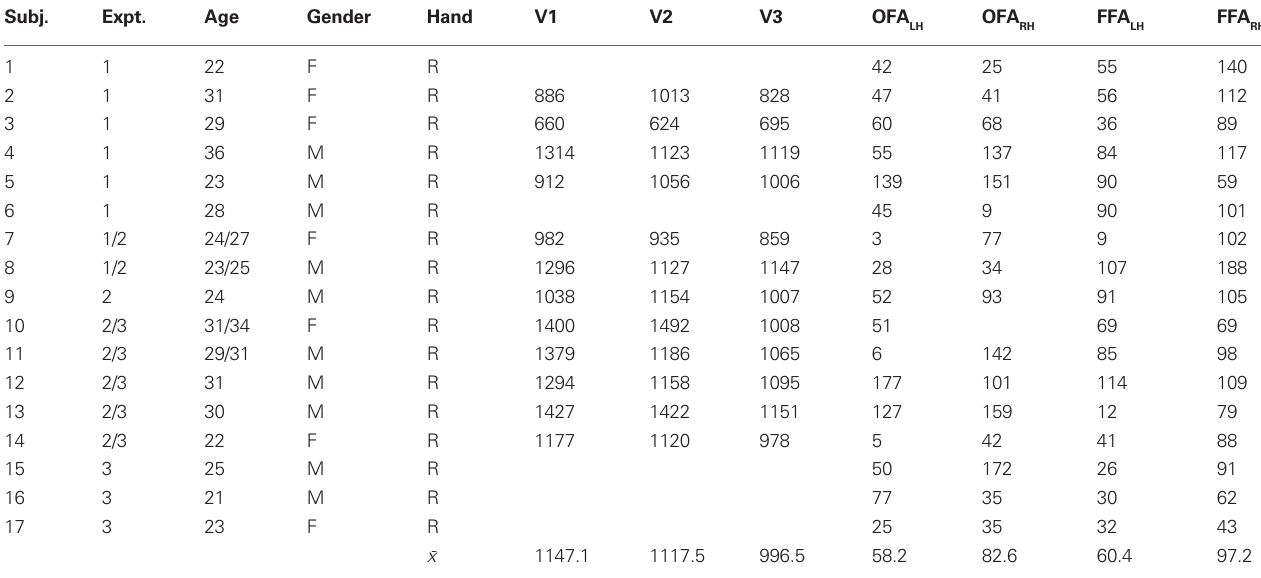
Table 1 | Demographic information, including age, gender, and handedness for each subject, and the number of voxels in each of the different regions of interest.